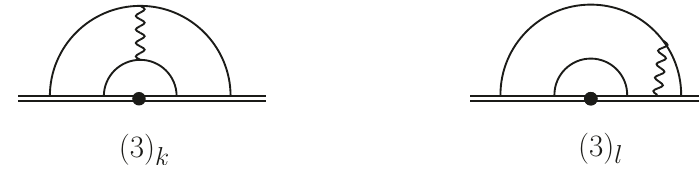
Figure 10 . Diagrams with four fermion insertions.